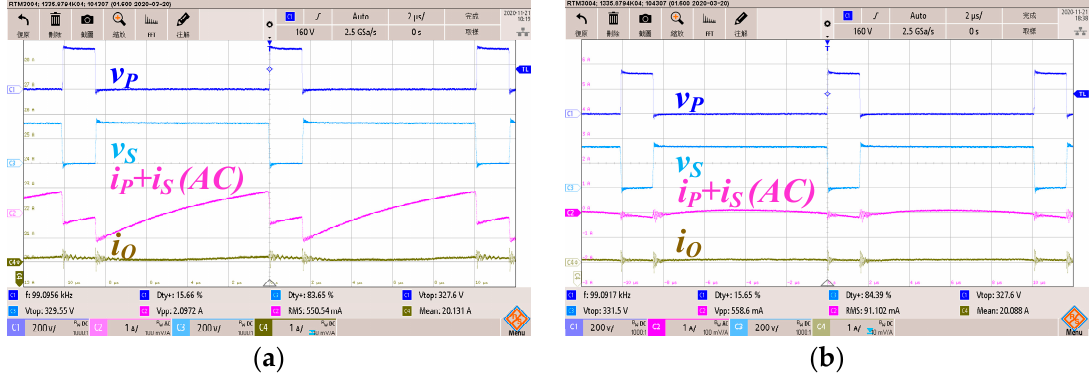
Figure 31. Measured waveforms of the switching node voltage and inductor current: ( a ) conventional dead time; ( b ) low output ripple dead time modulation. (scale v P (Ch1): 200 V/div; i P + i S (AC) (Ch2): 1 A/div; v S (Ch3): 200V/div; i O (Ch4): 1A/div; time: 2 µ